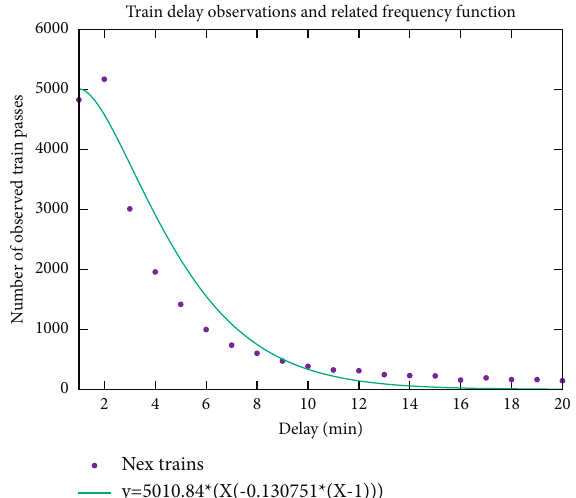
Figure 3: Example of Nex train category delay data histogram and related frequency function drawn as a continuous one to dem- onstrate its